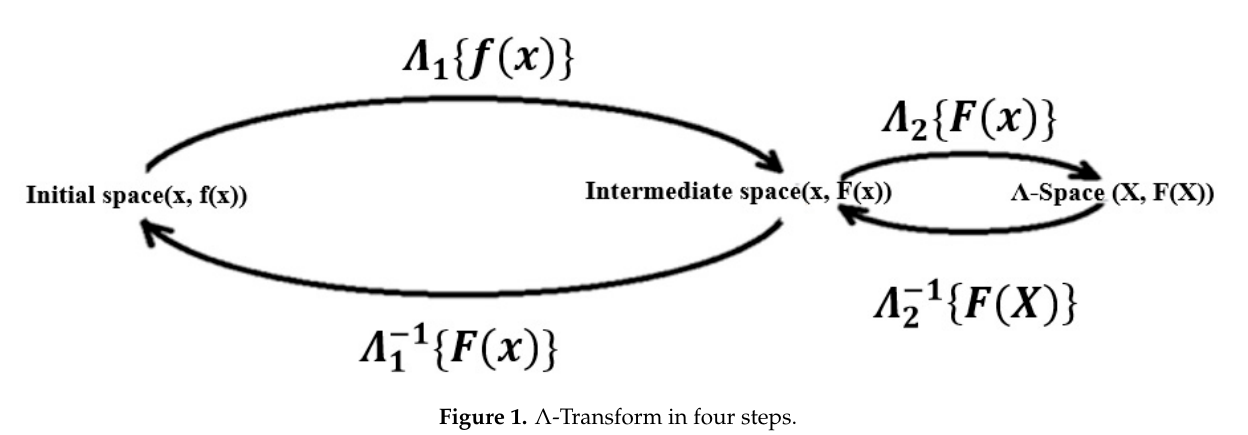
Figure 1. Λ -Transform in four steps.